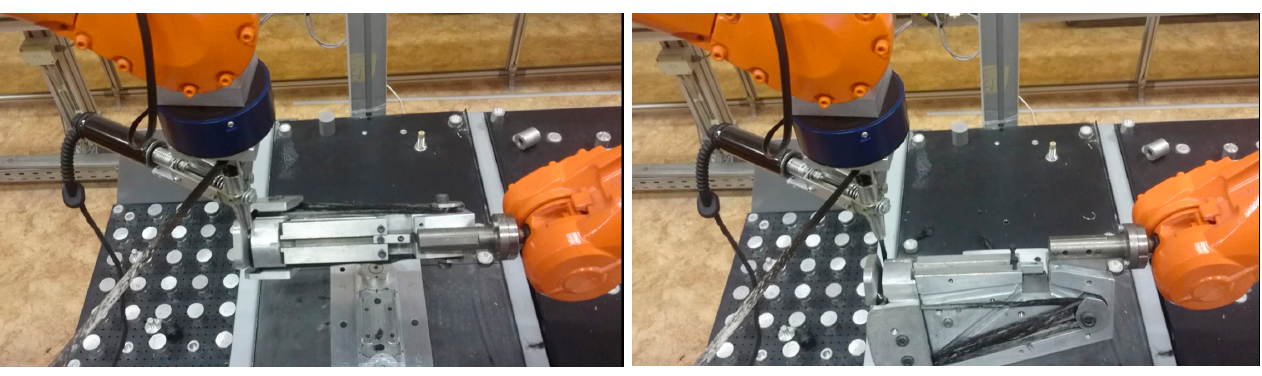
Figure 22. Real robot collaboration system.